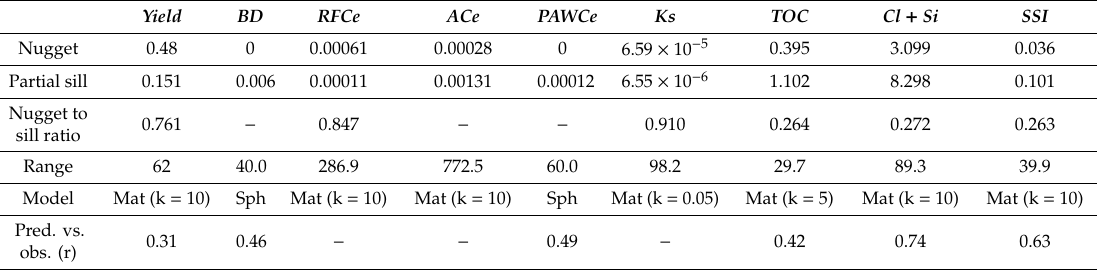
Table 4. Parameters of the theoretical variograms fitted to the studied variables.